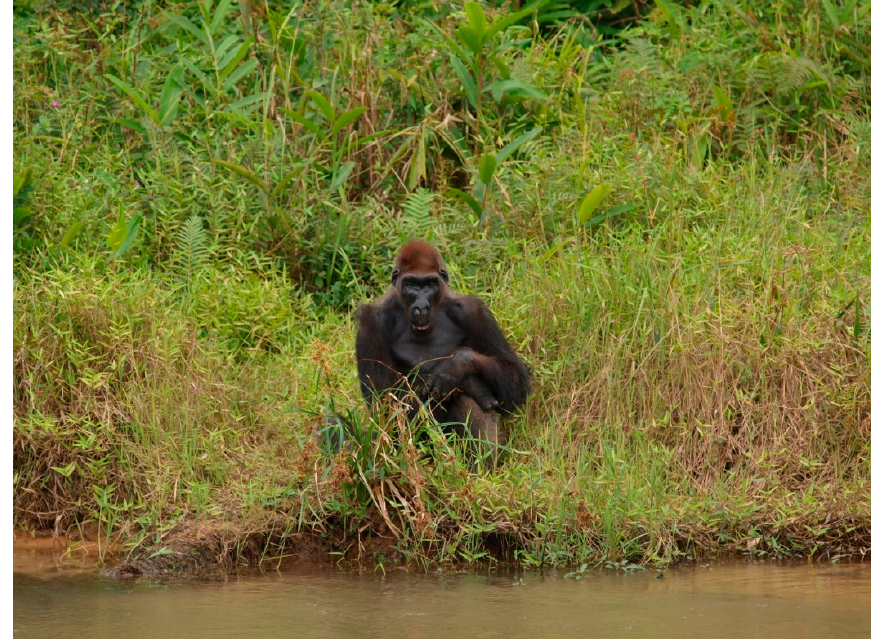
Figure 2. Gorilla ( Gorilla gorilla gorilla ) male individual (Sid) observed on a separate island in front of Abio station of Gorilla Lesio-Louna Nature Reserve. The individual presented with myodystrophy and facial paresis, suggesting a poliomyelitis-like sequelae may be due to the past enteroviral infection.